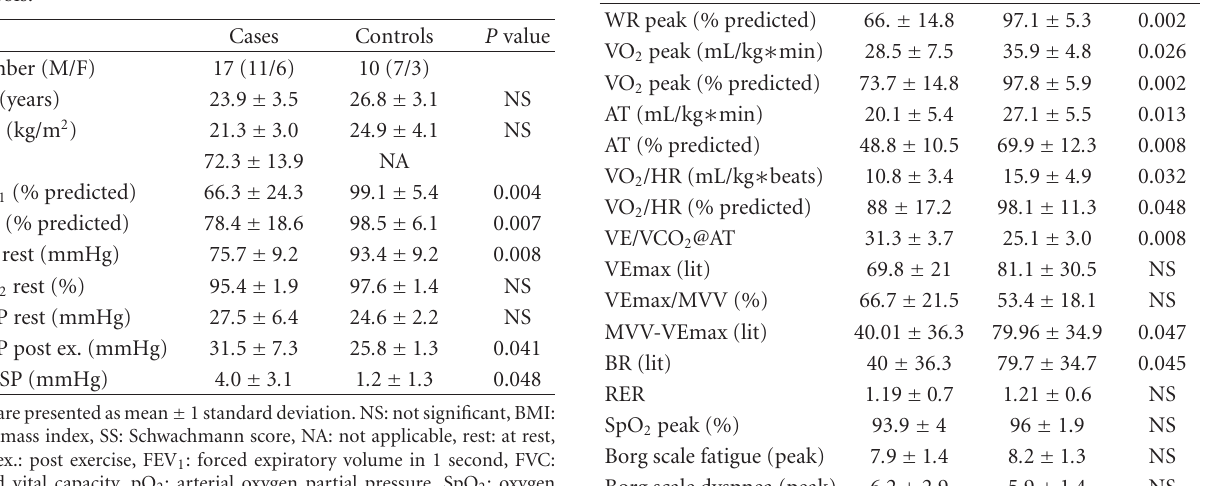
Table 1: Demographic characteristics, pulmonary function vari- ables and pulmonary artery pressure measurements in cases and controls.